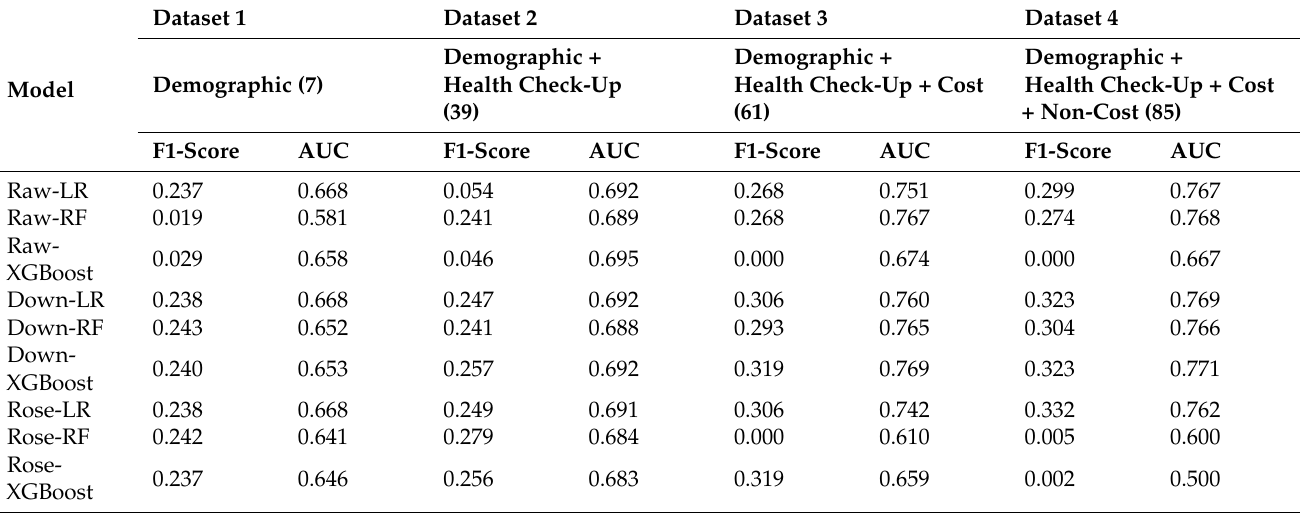
Table 5. Results of prediction model performance evaluation of the entire experimental